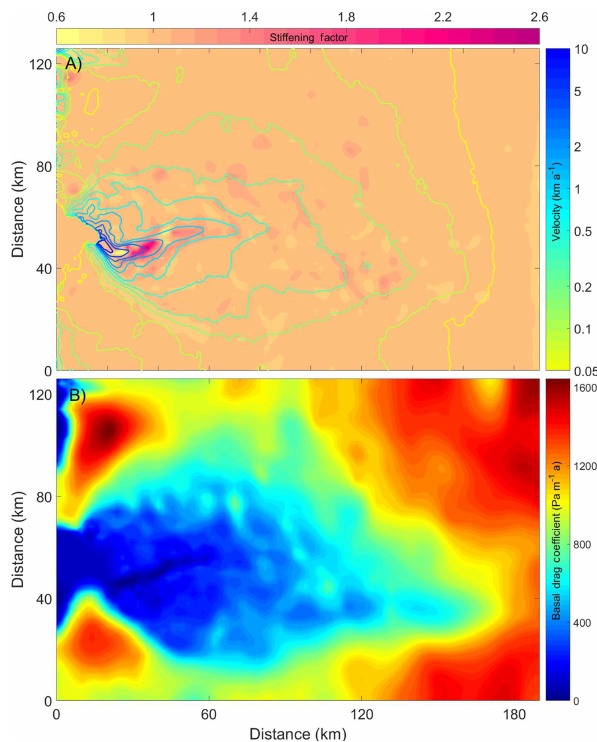
Figure 3. (a) Stiffening factor (cid:56) (Eq. 3) and (b) basal traction co- efficient C (Eq. 7) over the computational domain from solving the inverse problem. Contour lines in (a) show the modeled velocity (logarithmic